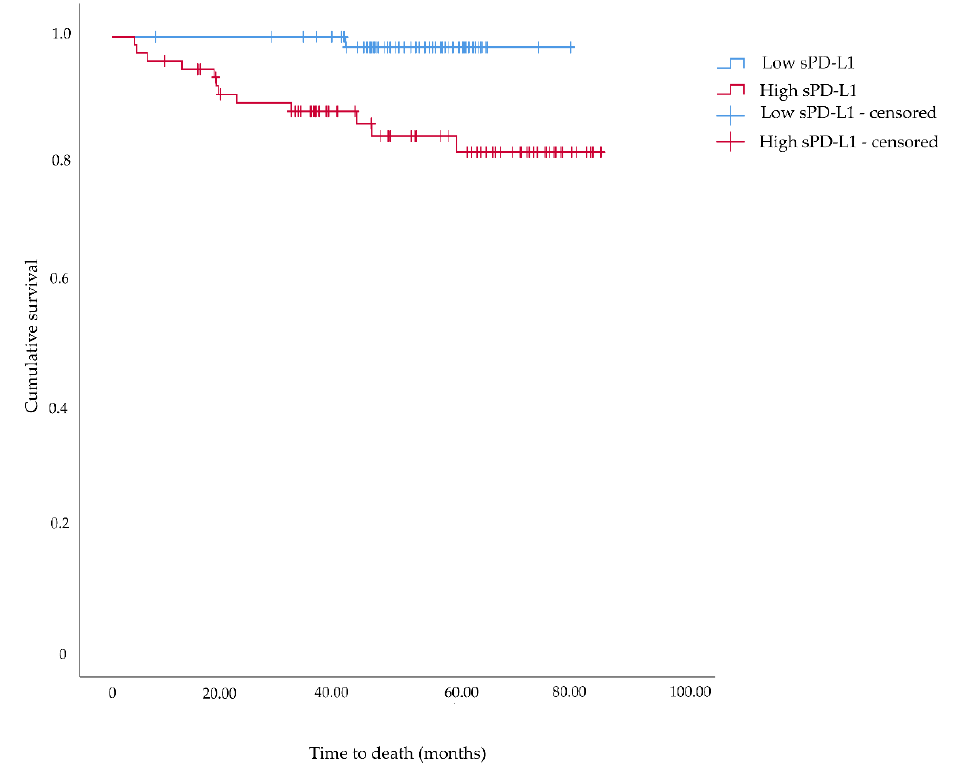
Figure 5. Kaplan–Meier survival plot for association of serum levels of soluble programmed death ligand 1 (sPD-L1) and cancer-specific survival among patients diagnoses with renal cell carcinoma.